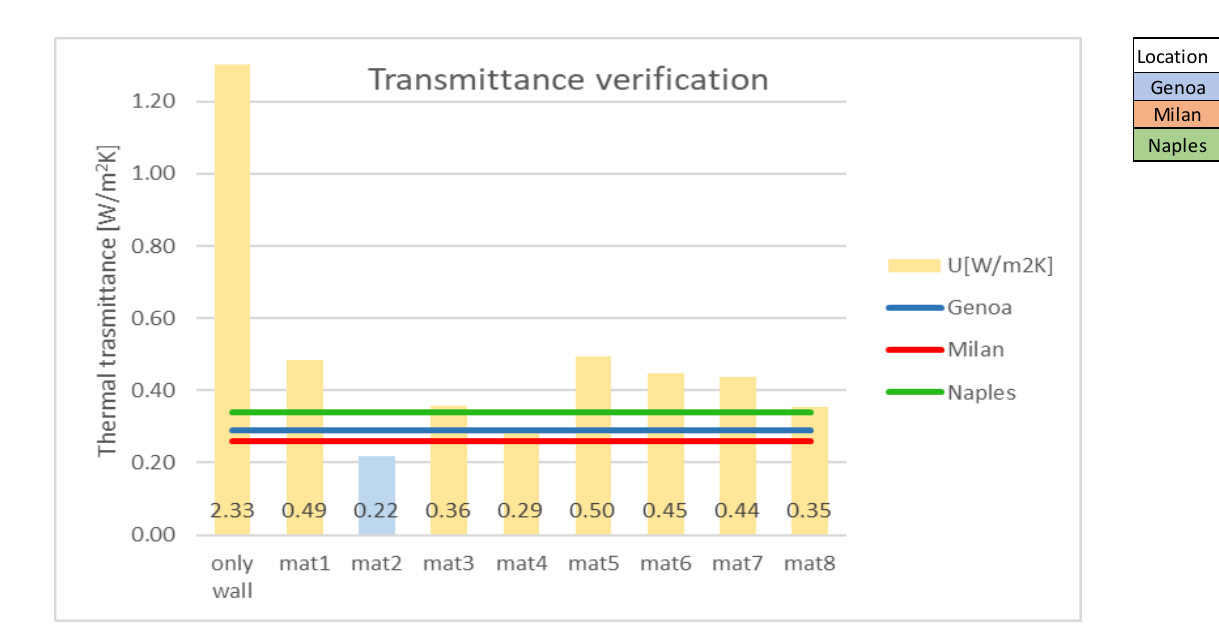
Figure 7. Thermal transmittance in stone walls with different heat reflective insulating layers. The red, blue, and green lines represent the threshold for different cities.